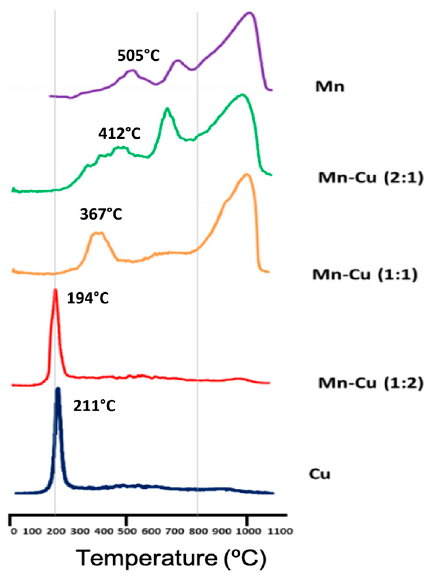
Figure 3. TPR-H 2 profiles for catalysts. Table 3. Superficial area BET and maximum temperature values of reduction by TPR-H 2 .